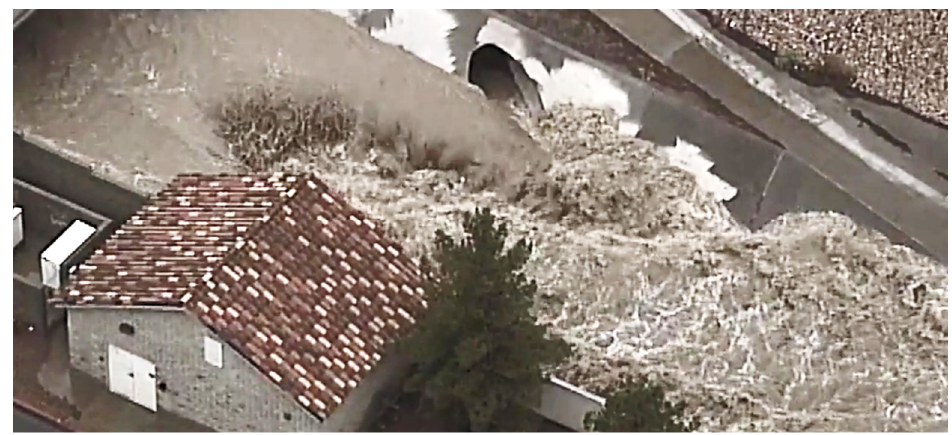
Figure 1. The confluence of an open channel with a lateral drainage pipe.